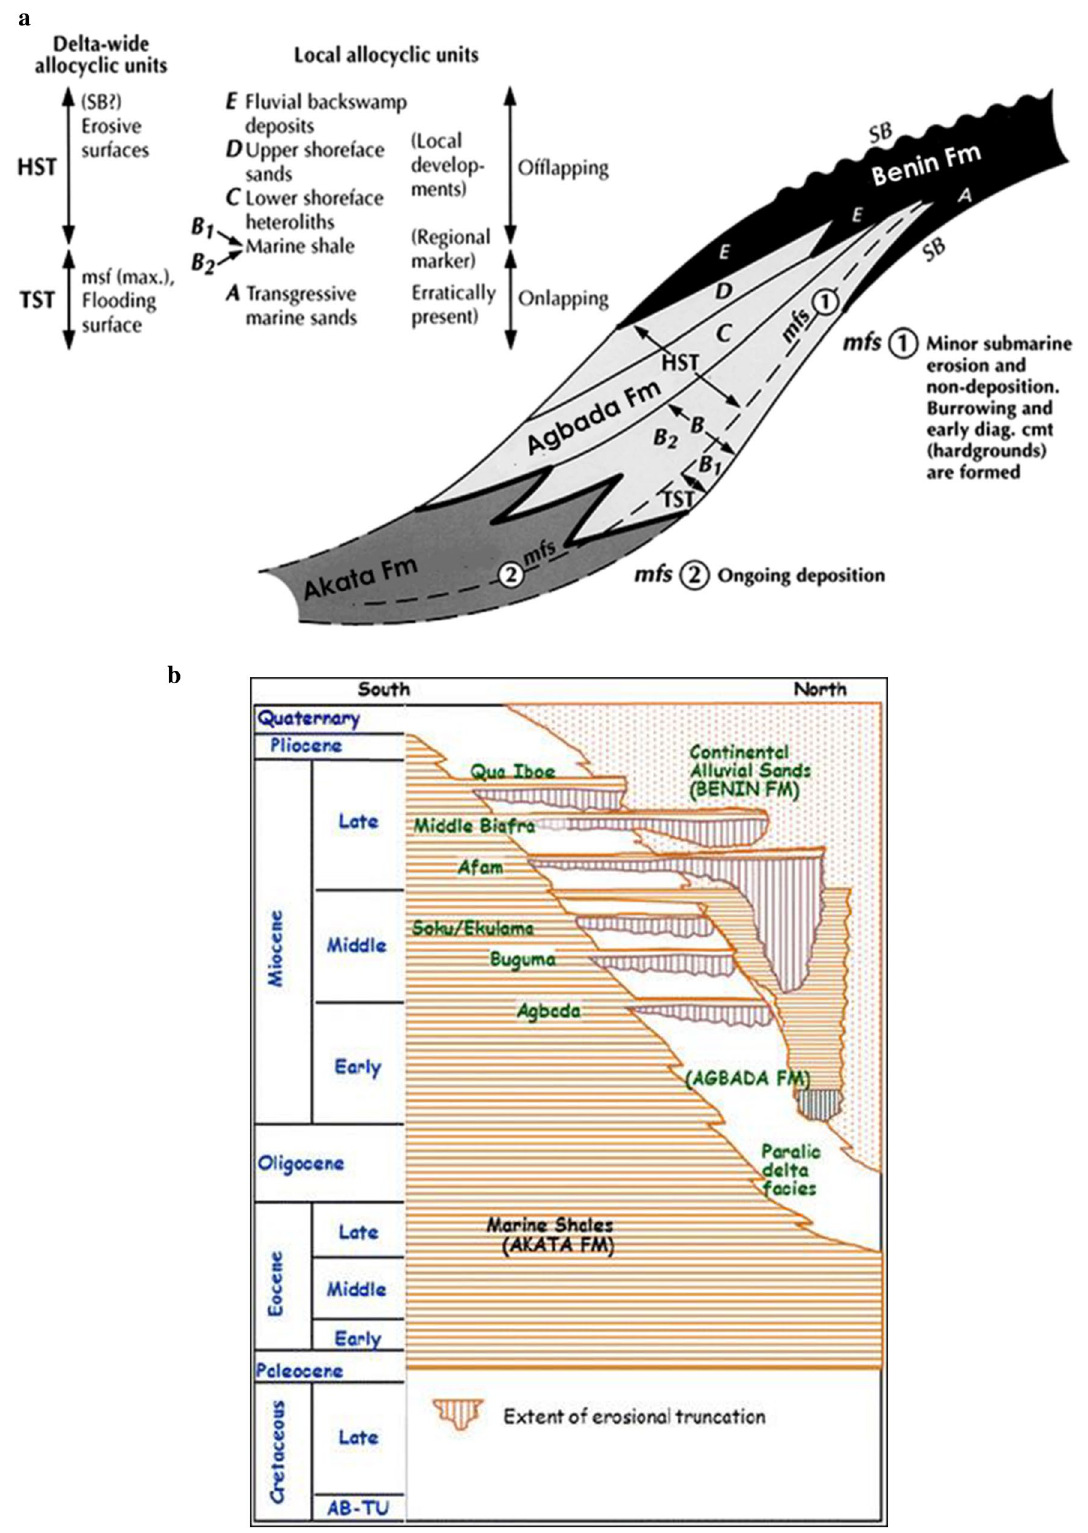
Fig. 2 a Schematic diagram showing the three allocyclic units of the three formations (adopted from Reijers 2011). b Stratigraphy of the Niger Delta showing the lithologic units of the three formations